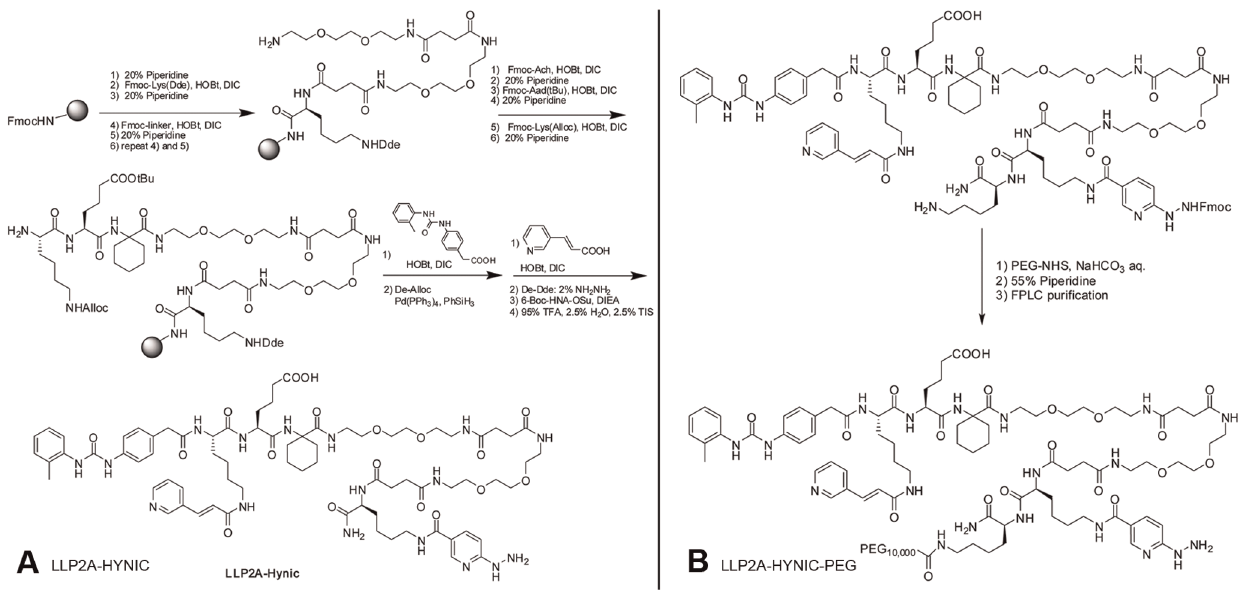
Figure 1. Synthesis of LLP2A-HYNIC and LLP2A-HYNIC-PEG. A. Synthetic approach for LLP2A-HYNIC. B. Synthetic approach of LLP2A-HYNIC- PEG.